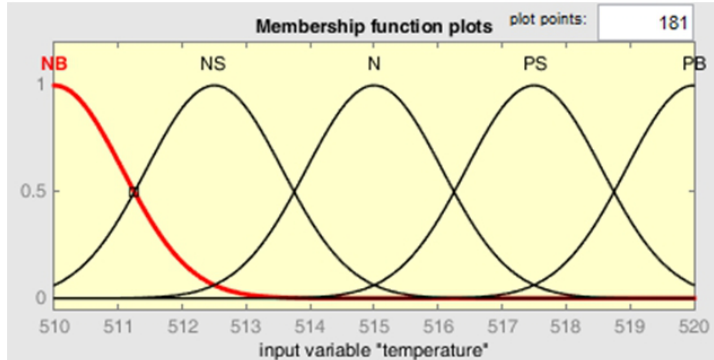
Figure 5. Membership function for the temperature within reactor.